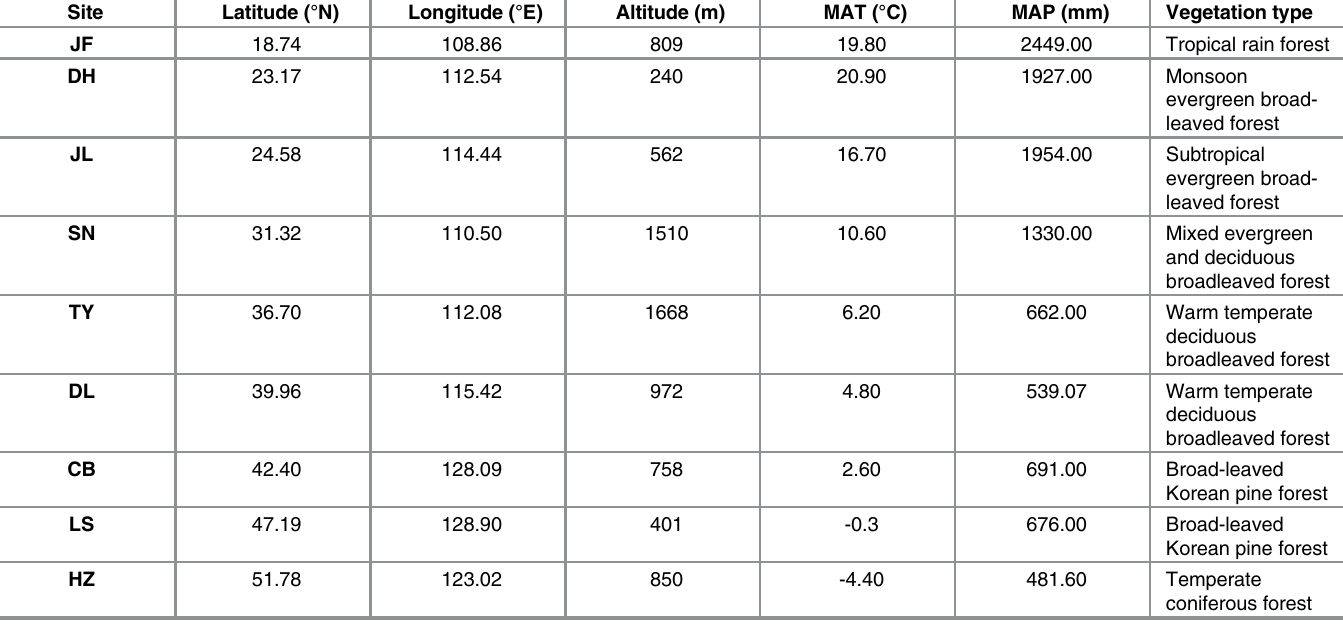
Table 1. Description of the study